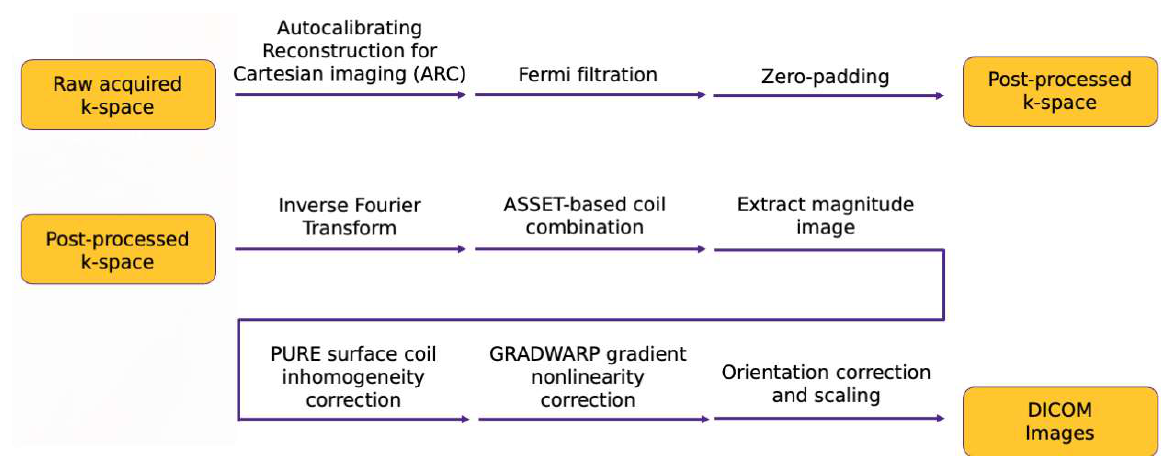
Figure 2. k-Space and image space post-processing steps for the in-house pipeline to reconstruct DICOM images from raw scanner data. Briefly, the steps in k-space are as follows: ARC reconstruction (parallel imaging), Fermi filtration to remove Gibbs artifacts, and zero-padding to bring the image to the intended output resolution. Image-space processing included coil combination, surface coil intensity correction, and gradient coil inhomogeneity correction.